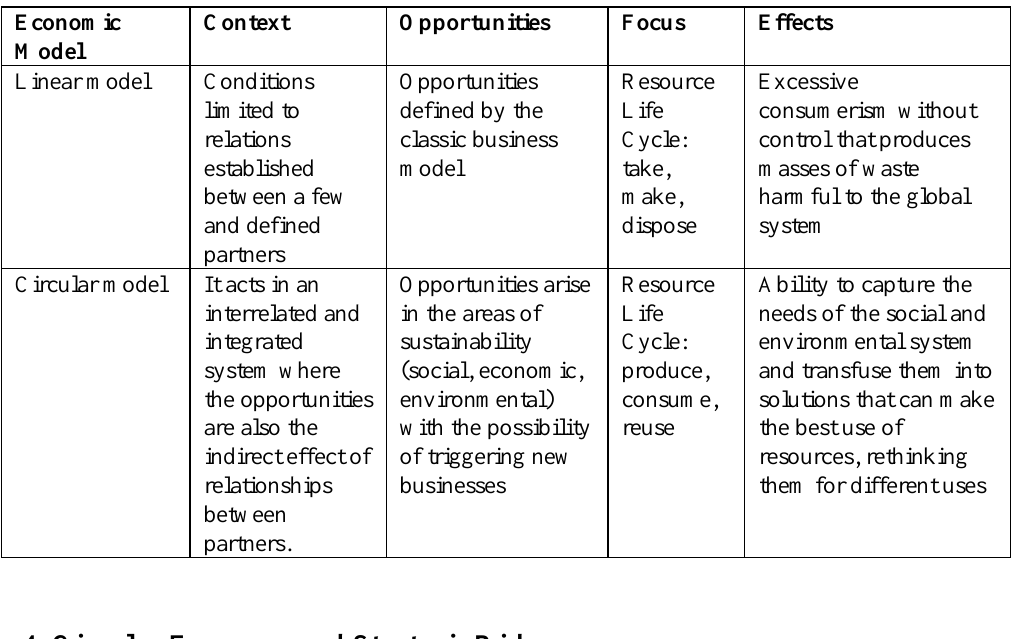
Table 1: From Linear to Circular Economy: The Effects of a New Corporate Vision Economic Context Focus Model Linear model